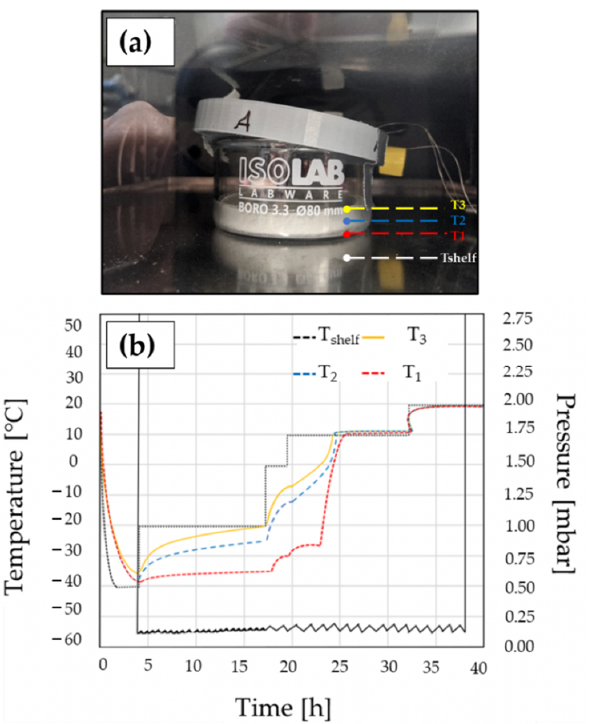
Figure 4. ( a ) Drying sample on a lyophiliser shelf with thermocouples (Tshelf—shelf temperature, T1—temperature of the bottom of the sample, T2—temperature of the middle of the sample, and T3—temperature of the top of the sample); ( b ) Lyophilisation drying protocol (shelf temperatures and vacuum level) with monitored temperatures.